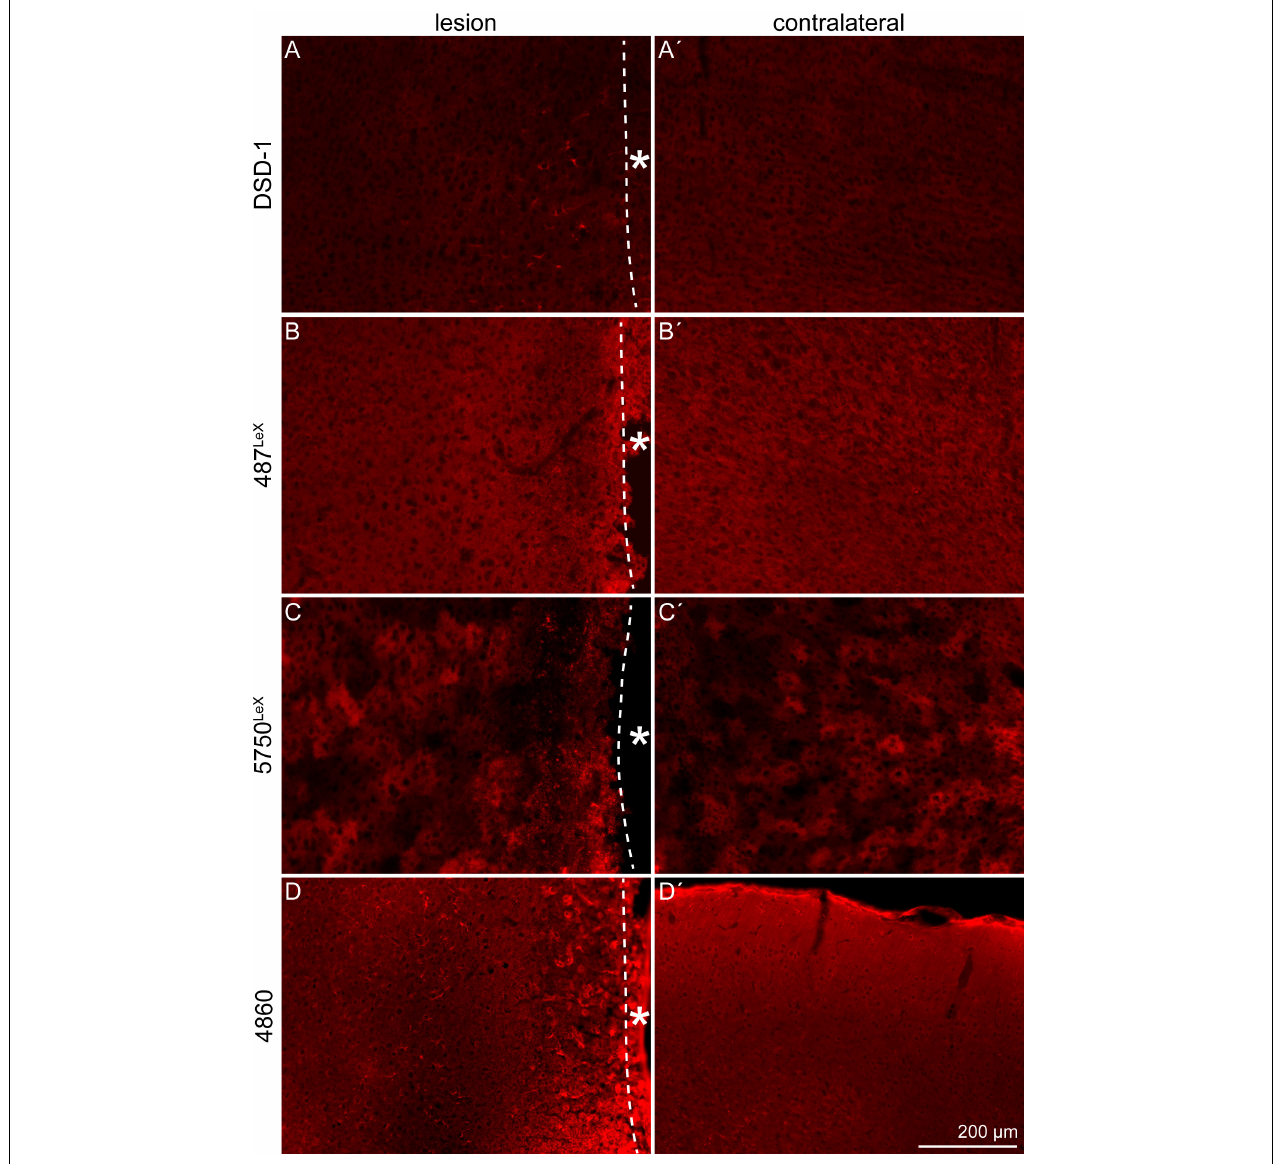
FIGURE 7 | Expression of the DSD-1, 487 LeX , 5750 LeX , and 4860 glycoepitopes, 3 dpl. (A,A (cid:48) ) The DSD-1 glycoepitope was detected on cells, restricted to the penumbra. (B,B (cid:48) ) Staining with mAb 487 LeX did not show a lesion-specific expression of the epitope. (C,C (cid:48) ) The 5750 LeX staining revealed a characteristic, patchy expression pattern that was not altered in the penumbra. (D,D (cid:48) ) The 4860 epitope was found on distinct cells in the penumbra, in contrast to a diffuse staining in the healthy hemisphere. Asterisk: direction toward the lesion core; scale bar: 200 µ m.